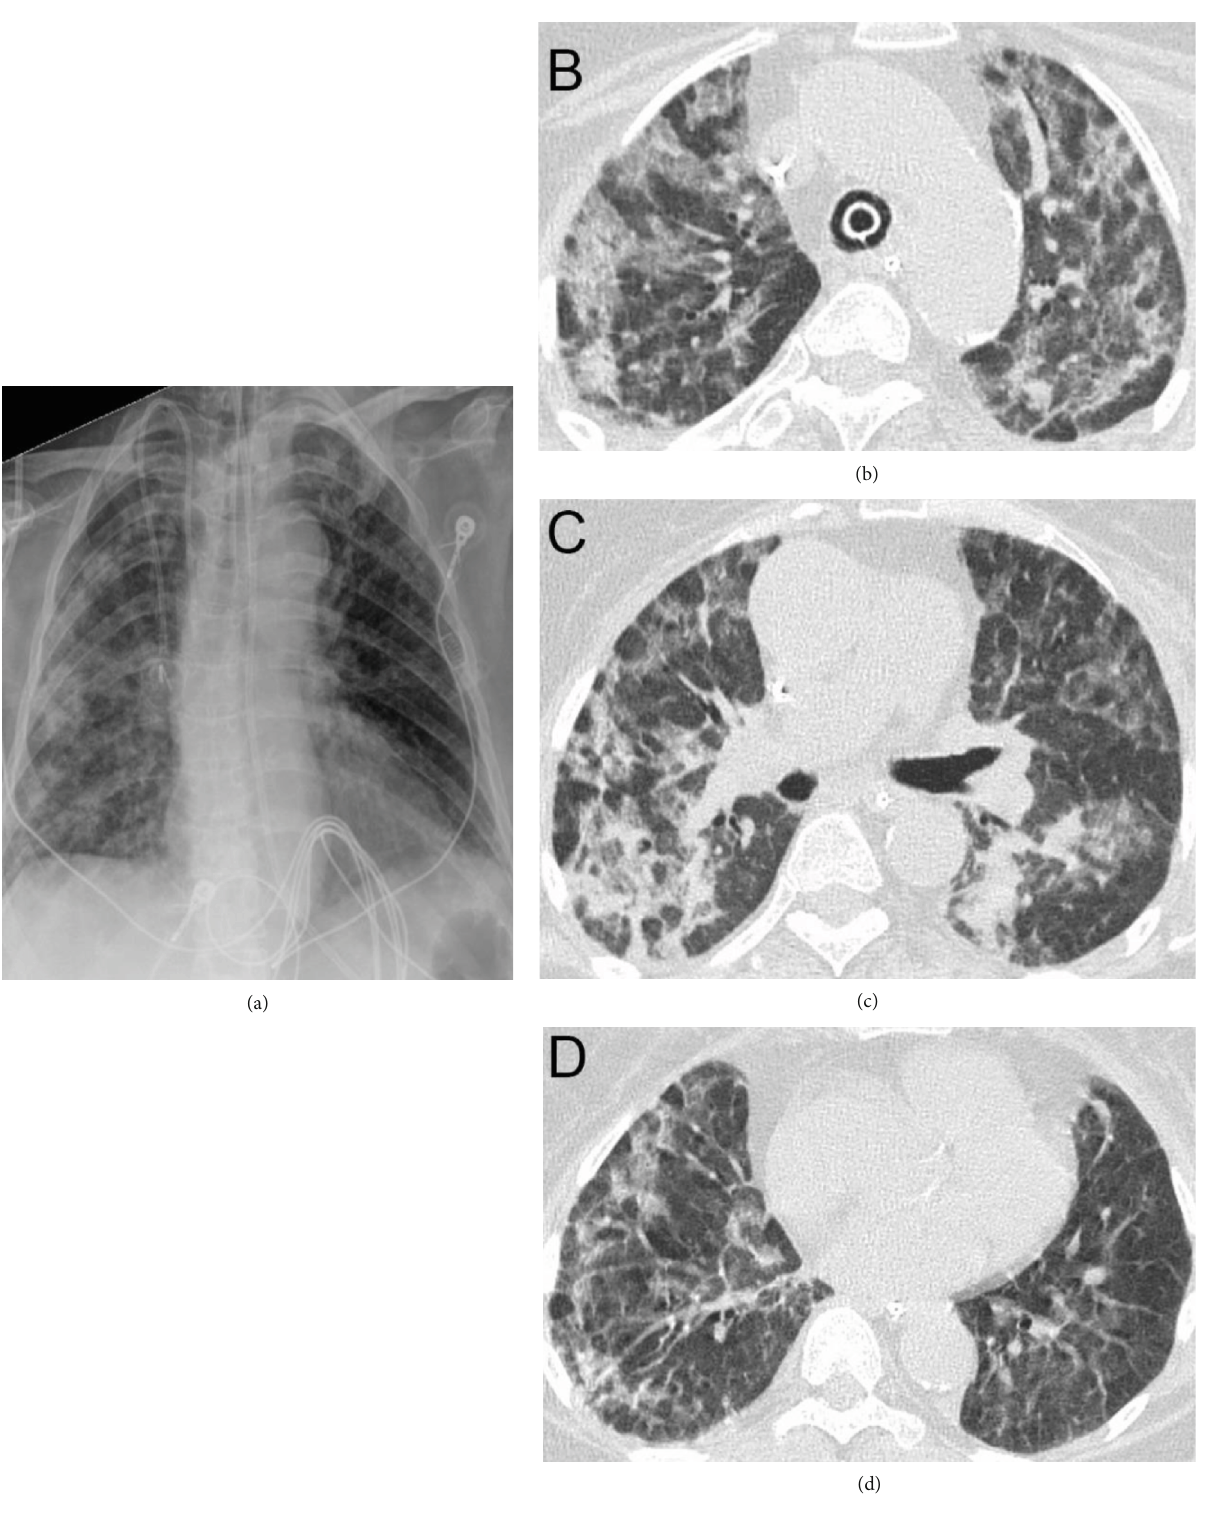
Figure 3: Imaging on HD#16 after an acute hypoxic event. (a) CXR with a new endotracheal tube and persistent di ff use lung disease. (b – d) CT scan of the lungs at upper (b), mid (c), and base (d) illustrating continued peribronchial consolidation and decreased ground glass opacities. An endotracheal tube can be seen in the